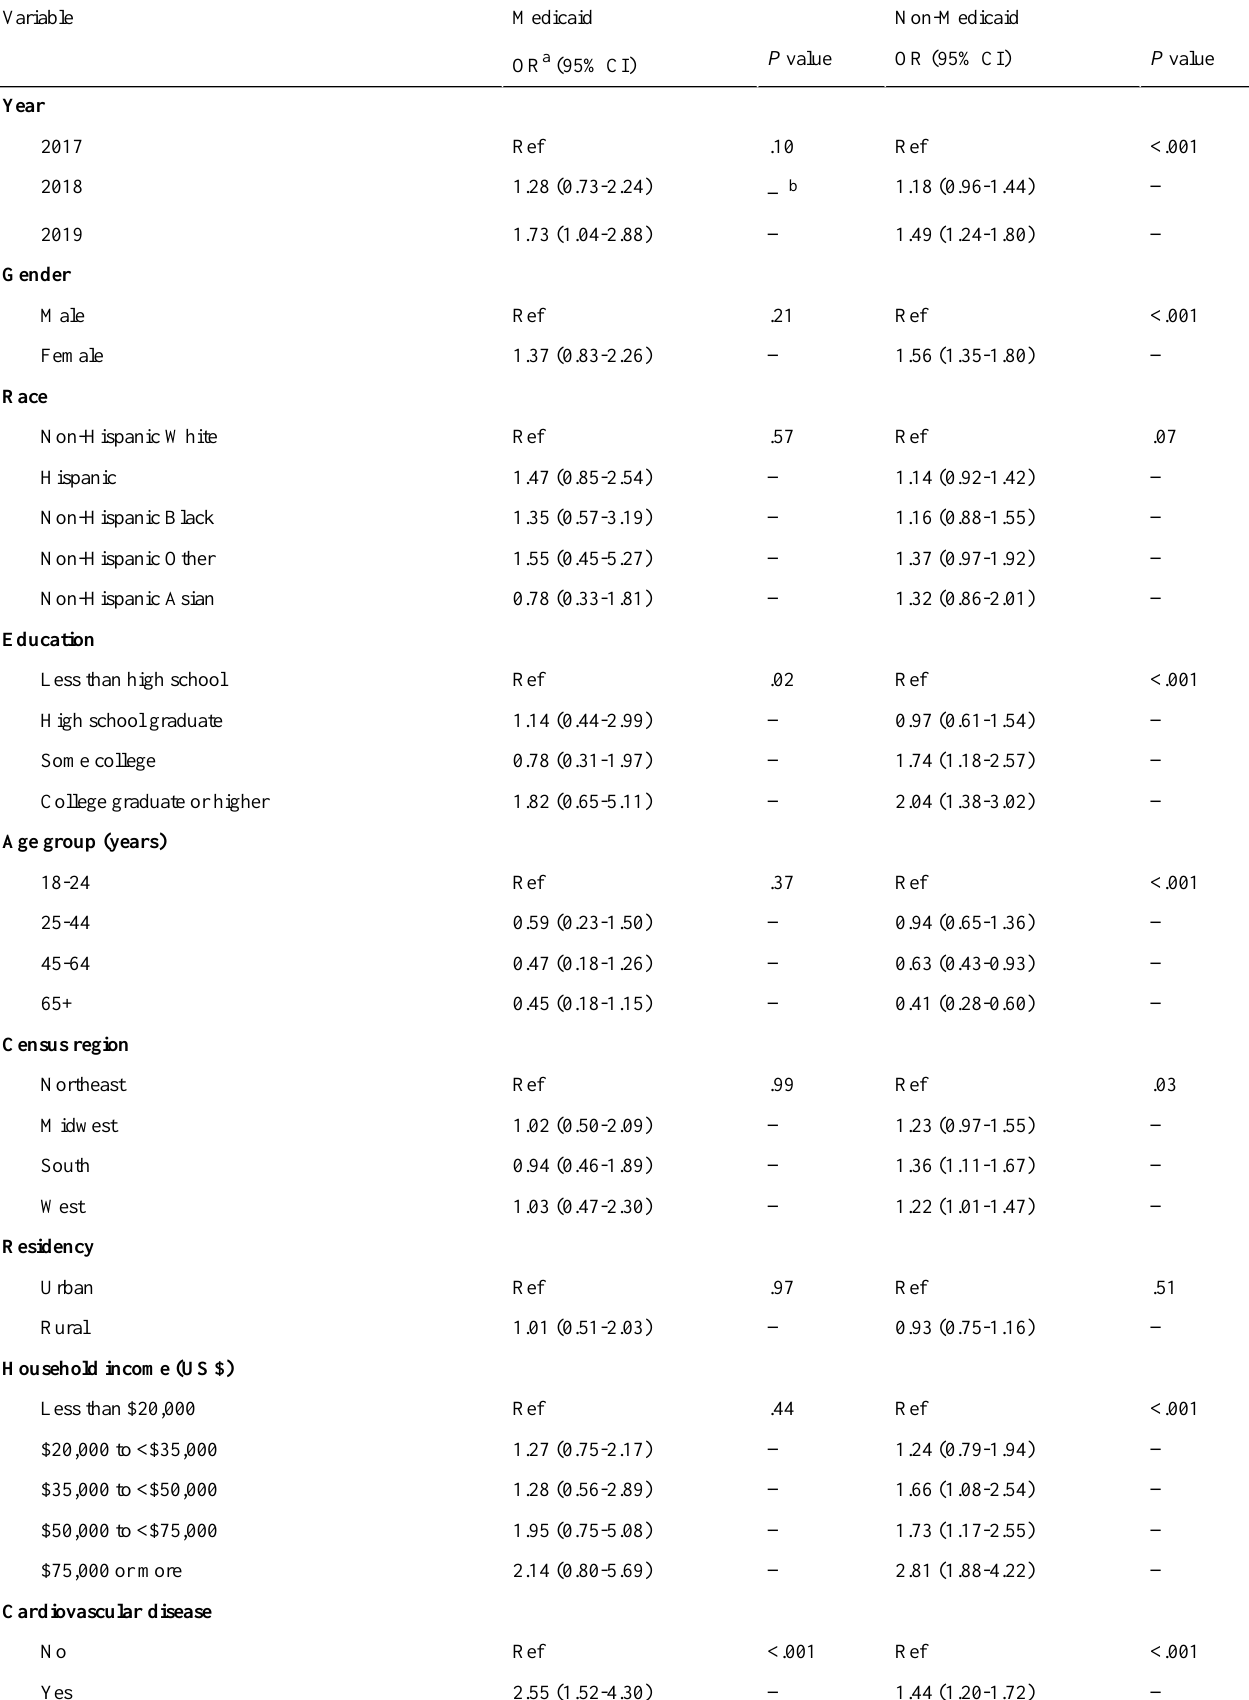
Table 4. The odds ratio of predictors for mobile health for self-regulation among Medicaid and non-Medicaid participants.